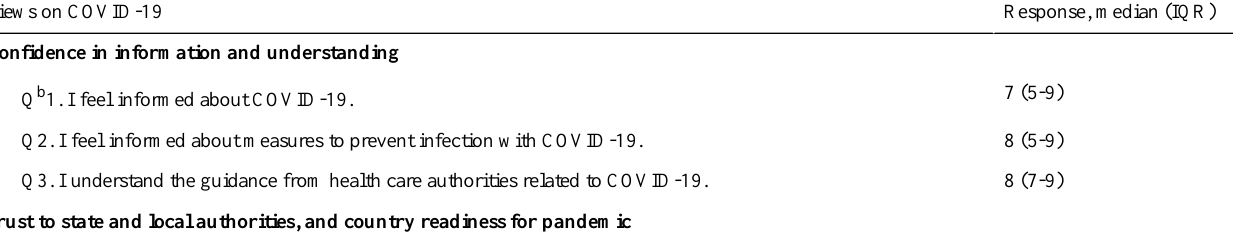
Response, median (IQR)Views on